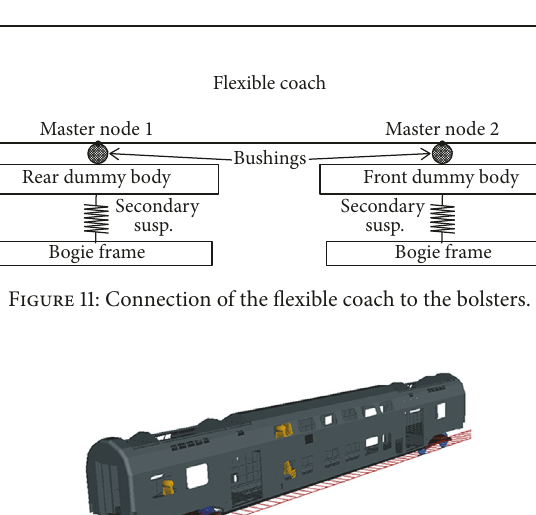
Figure 14: Modal shape of the 5th mode at 12.07